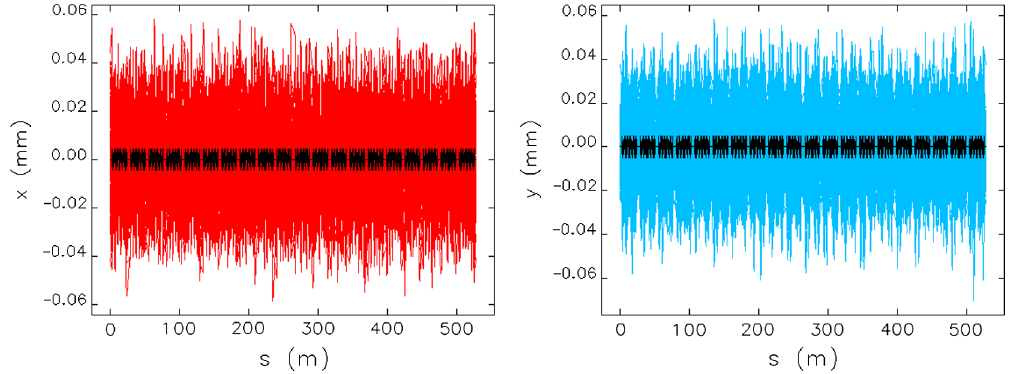
FIG. 9. Corrected closed orbits along the storage ring for 100 seeds of random errors: (left) horizontal orbit, (right) vertical orbit.